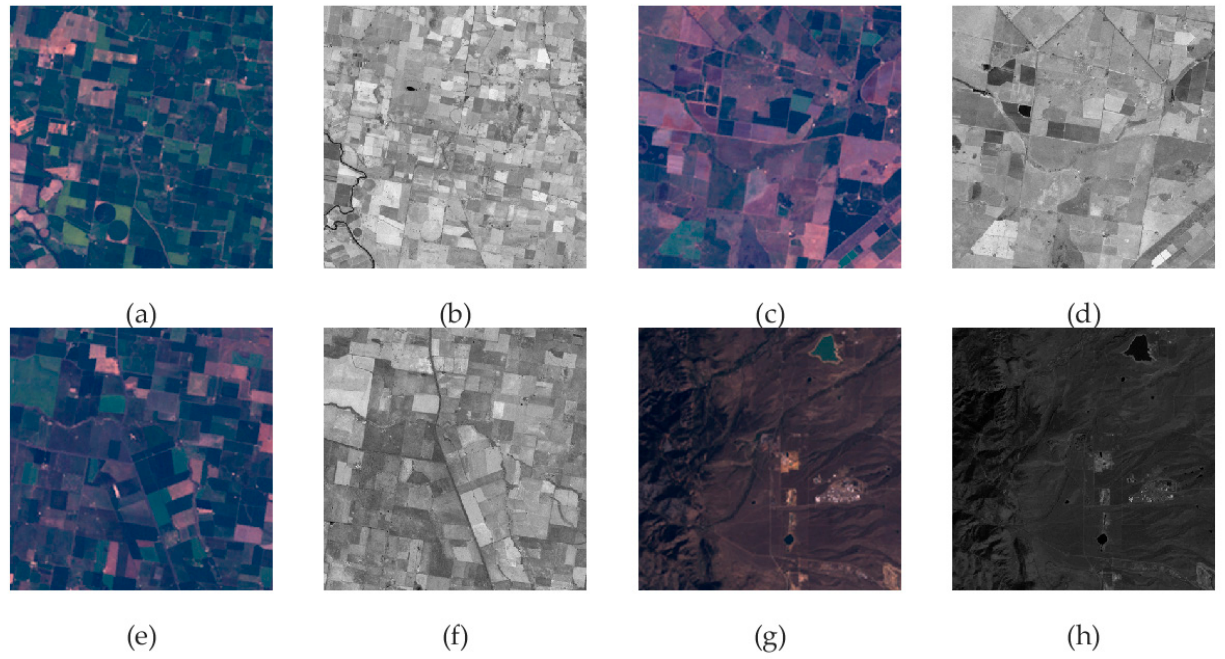
Figure 5. Four image pairs of the MS and PAN image.